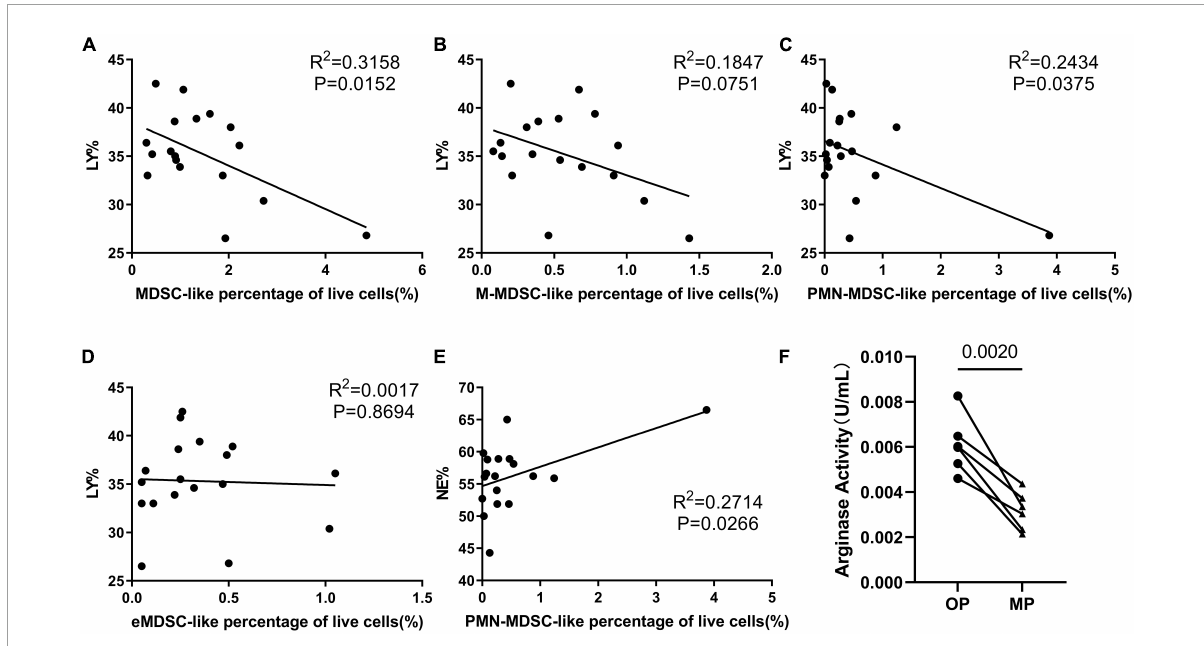
FIGURE3 The immunosuppressive ability of myeloid-derived suppressor cell-like (MDSC-like) cells. Correlation analysis evaluating the relationship between several different indices, including correlation between lymphocyte percentage and (A) MDSC-like cells percentage, (B) monocytic-MDSC-like (M-MDSC-like) cells, (C) granulocytic-MDSC-like (PMN-MDSC-like) cells, and (D) early-stage-MDSC-like (eMDSC-like) cells. (E) Correlation between neutrophil percentage and PMN-MDSC-like cells percentage. (F) Arginase activity in the MDSC-like cells from six volunteers in the ovulation period (OP) and menstrual period (MP) groups.